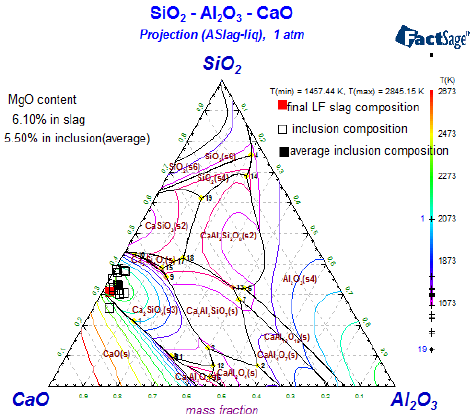
Figure 6. Chemical composition of inclusions and slag at the final stage of the LF process.